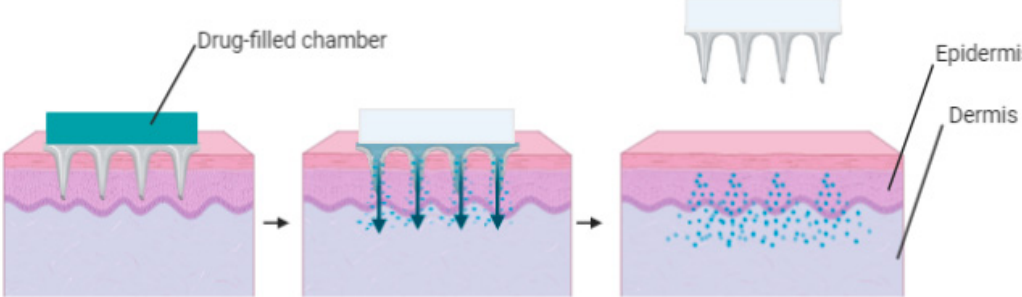
Figure 3. Illustration of poke and flow using hollow microneedles . Hollow microneedles provide a specific channel for the delivery of drugs to the